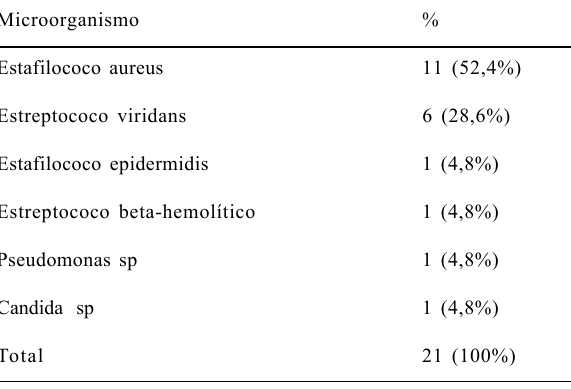
Tabela 2. Hemocultura positiva – microorganismo